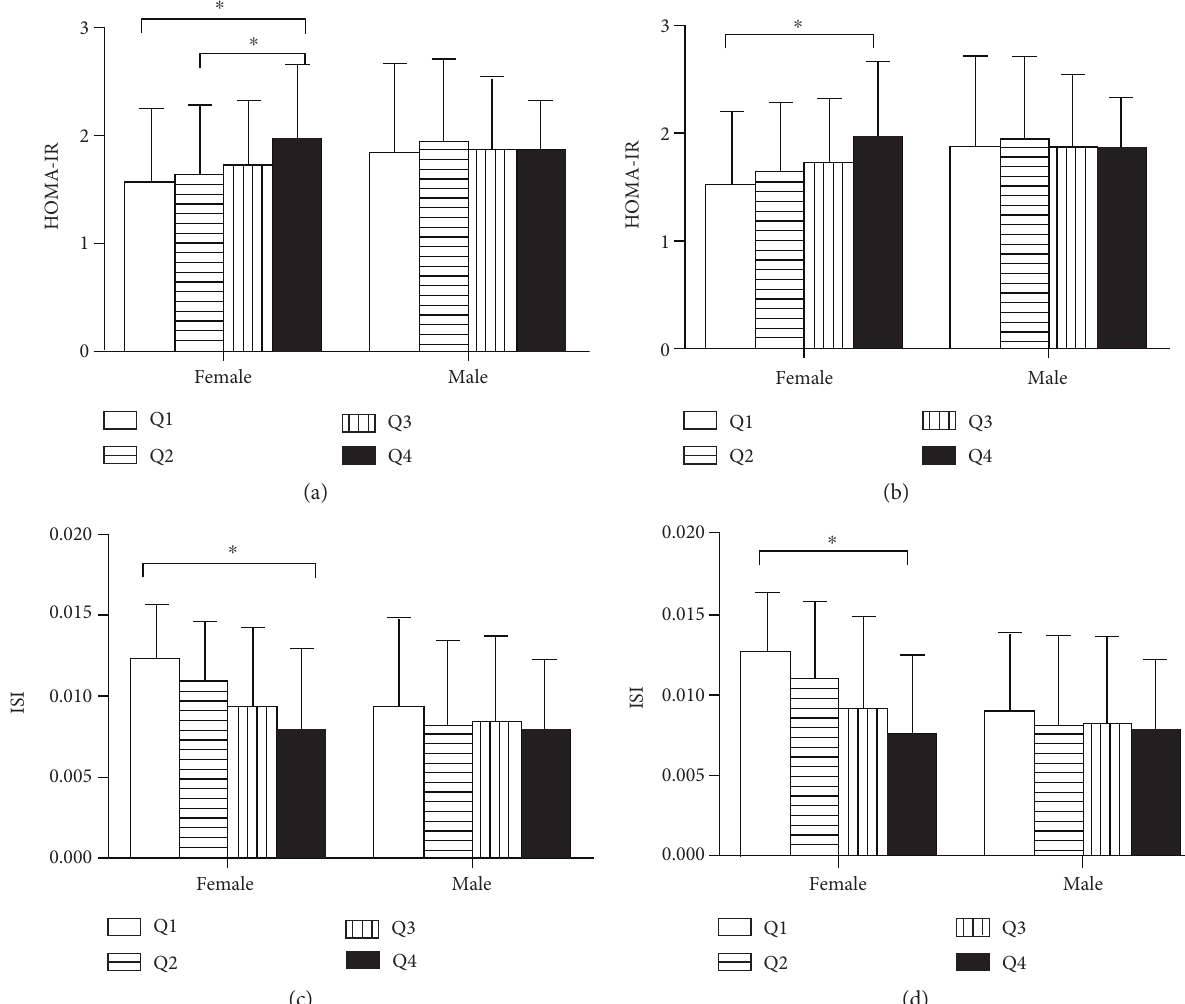
Figure 2: Unadjusted and adjusted HOMA-IR and ISI level in each quartile of serum UA (Q1, Q2, Q3, and Q4) in male and female participants. (a) Unadjusted HOMA-IR was found to signi fi cantly increase across the quartiles in females while no signi fi cant di ff erence was observed in males. (b) After adjusting for age, SBP, DBP, AST, and WHR, the HOMA-IR levels signi fi cantly increased across the quartiles in females while no signi fi cant di ff erence was observed in males. (c) Unadjusted ISI was found to signi fi cantly decrease across the quartiles in females while no signi fi cant di ff erence was observed in males. (d) After adjusting for the abovementioned factors, ISI levels signi fi cantly decreased across the quartiles in females while no signi fi cant di ff erence was observed in males. ∗ P < 0 05